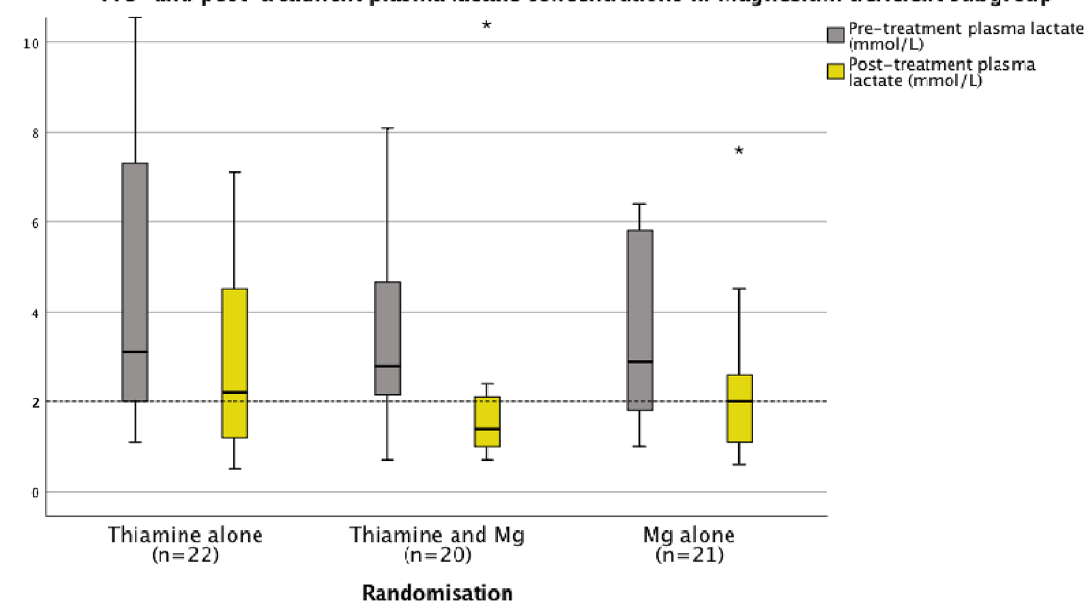
Figure 8. Pre- and post-treatment plasma lactate in the context of low circulating serum magnesium.